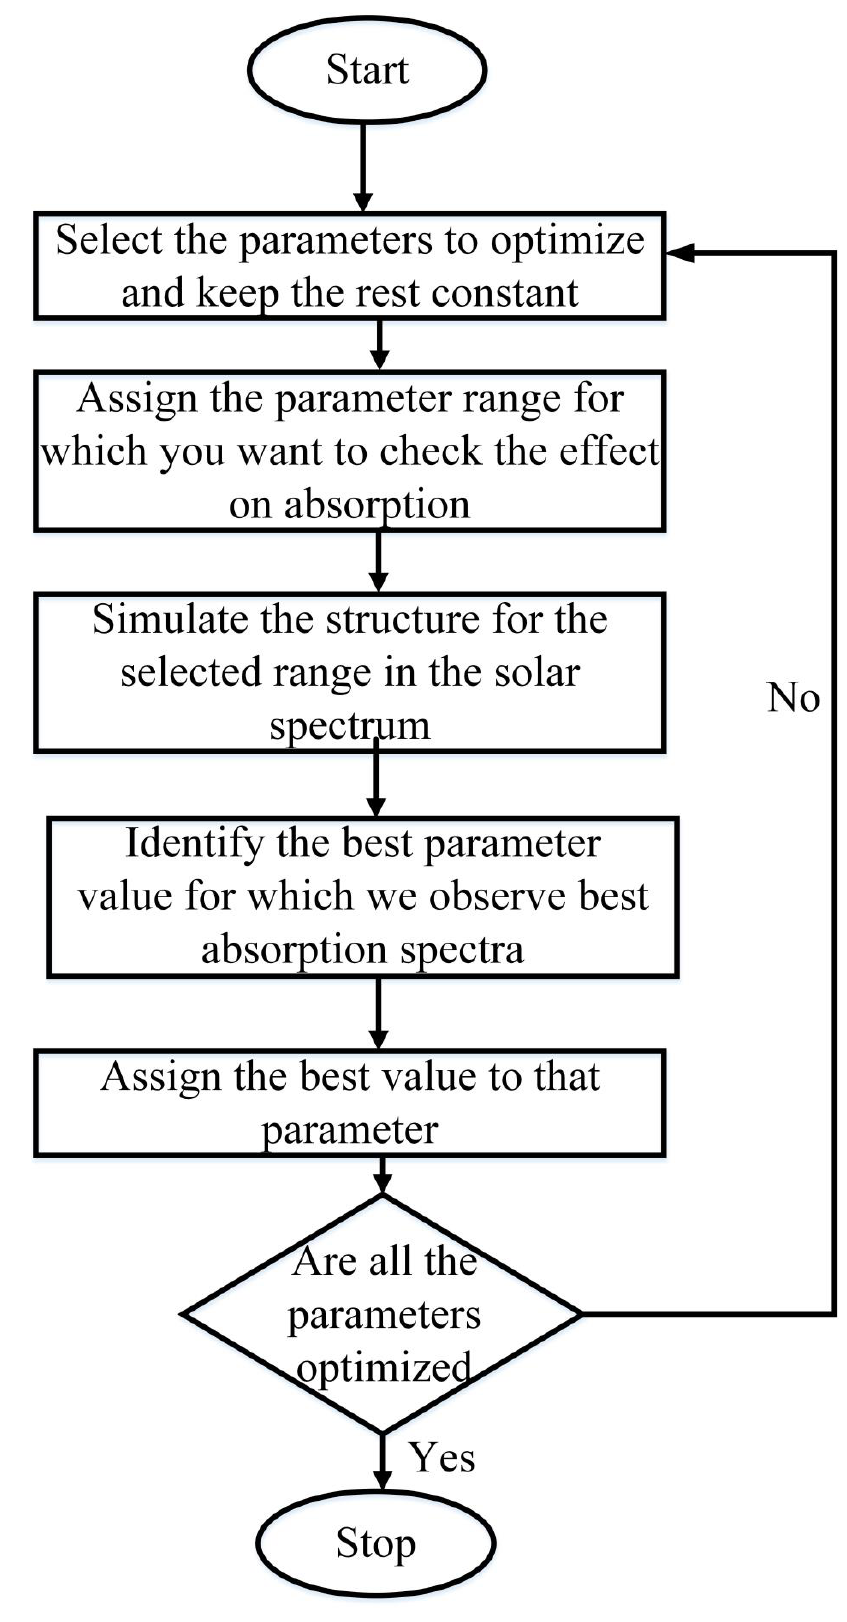
Figure 4. Flowchart describing the process of structural parameter optimization.